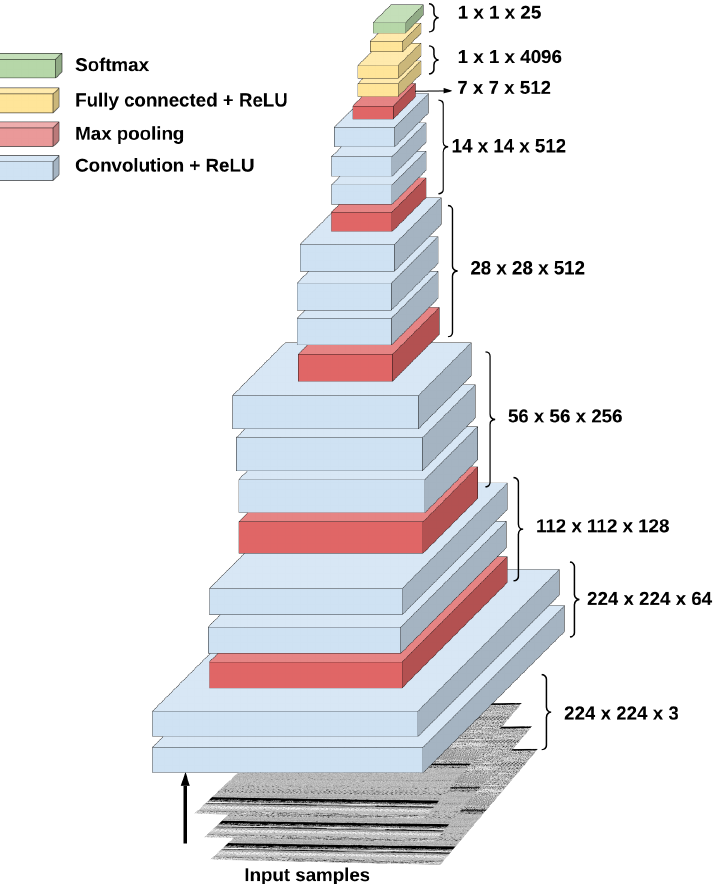
Figure 2. Architecture of the fine-tuned VGG16